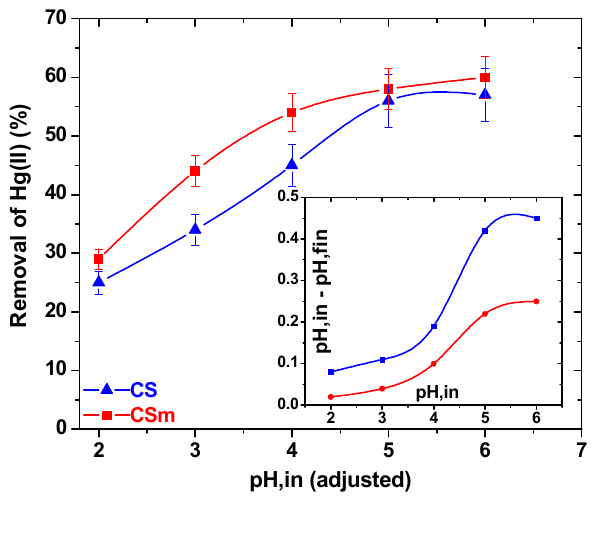
Figure 8. Effect of pH on adsorption (Inset: Change of pH between initial/adjusted conditions and